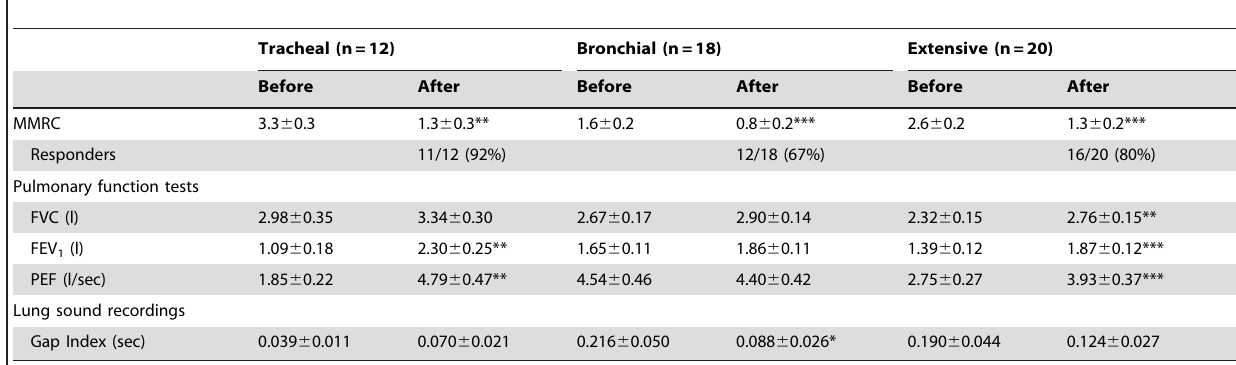
Table 3. Dyspnea scale, pulmonary function tests and lung sound recordings before and after intervention.